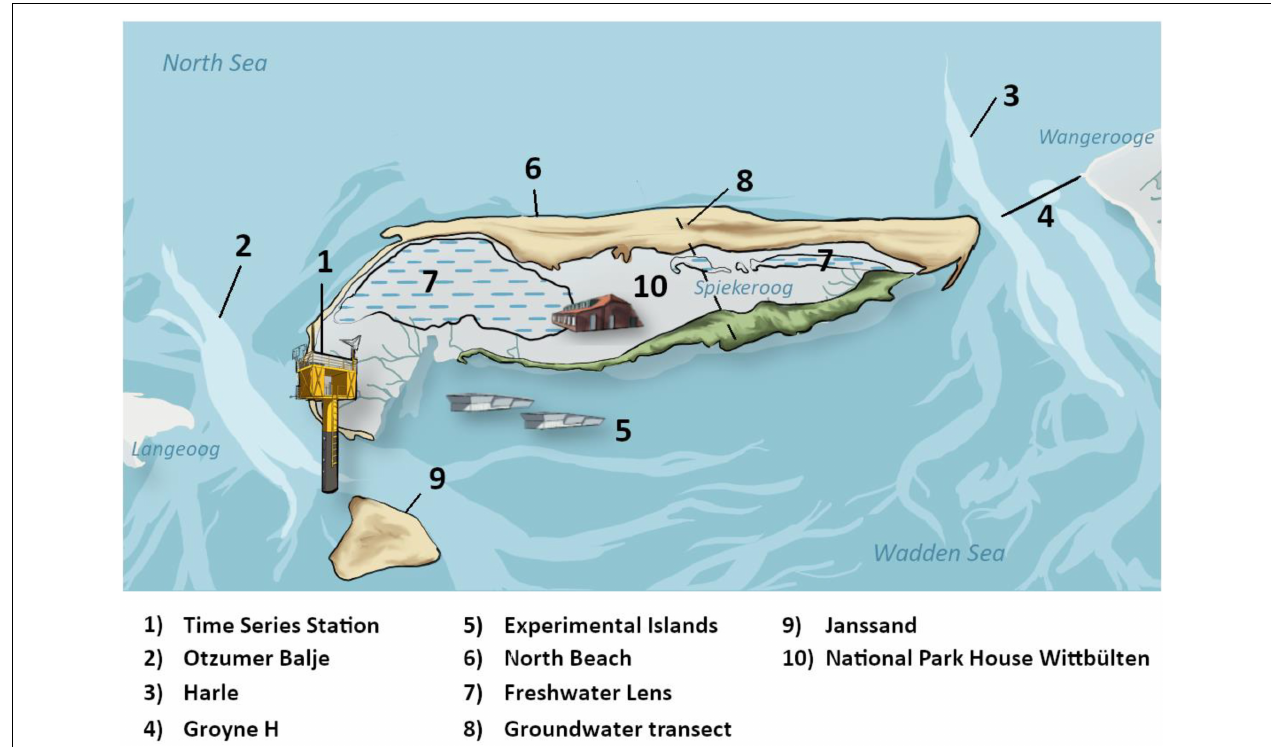
FIGURE 3 | SCO Study sites. The Spiekeroog Coastal Observatory (SCO) represents a combination of long-term exploration sites (1, 5, 7, 8) as well as campaign-based research sites (2, 3, 4, 6, 9). (1) The Time-Series Station Spiekeroog is continuously recording oceanographic, meteorological, and biogeochemical data since 2002. (5) Experimental islands and salt marsh enclosed plots were established in 2014 exploring interactions of plants and animals within a metacommunity framework. Abiotic and biotic data is observed since the set-up. (8) A long-term groundwater monitoring transect was installed in north-south direction at the western part of the Ostplate in 2016 investigating the simultaneous evolution of dunes and accompanying freshwater lenses (7). Both, the North Beach (6) and the Janssand (9) serve as campaign-based research sites since 2014 and respectively 2002. (10) A modern research center was established in 2011 on Spiekeroog providing laboratory, training rooms, and accommodations for scientists. The Gute Küste Niedersachsen project is a good example, successfully using many different components of the SCO. It combines research at different sites around and on the island and will conduct research campaigns at the tidal channels Otzumer Balje (2) and Harle (3) with special consideration of the artificial coastal protection measure Groyne H